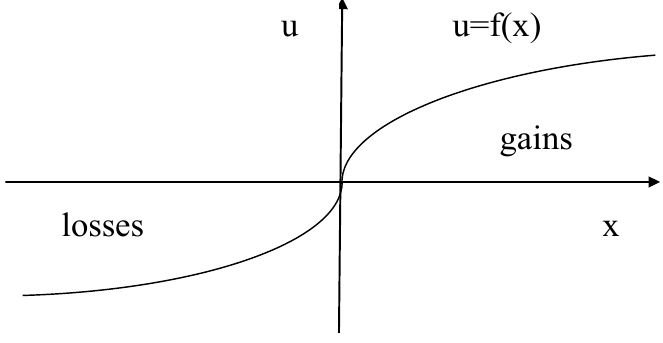
Figure 2. An example form of the utility function.